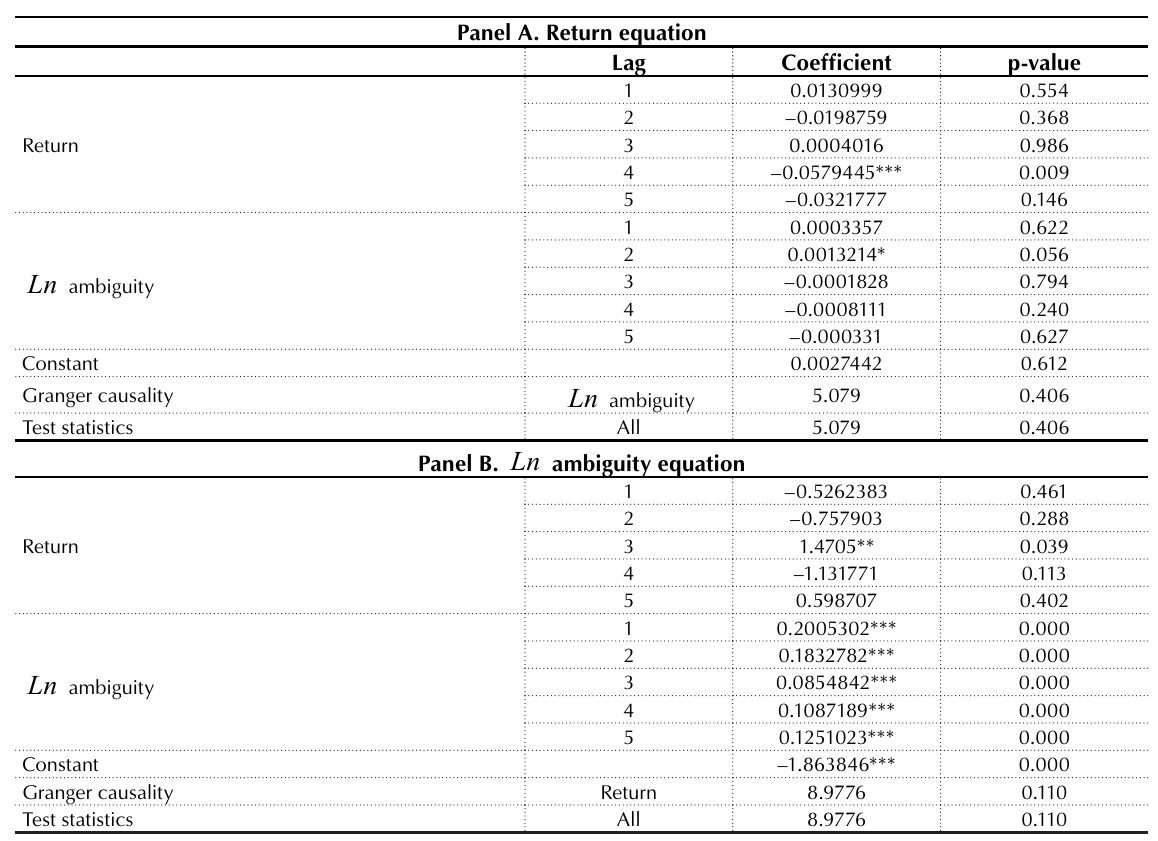
Table 7. VAR result with 5 lags